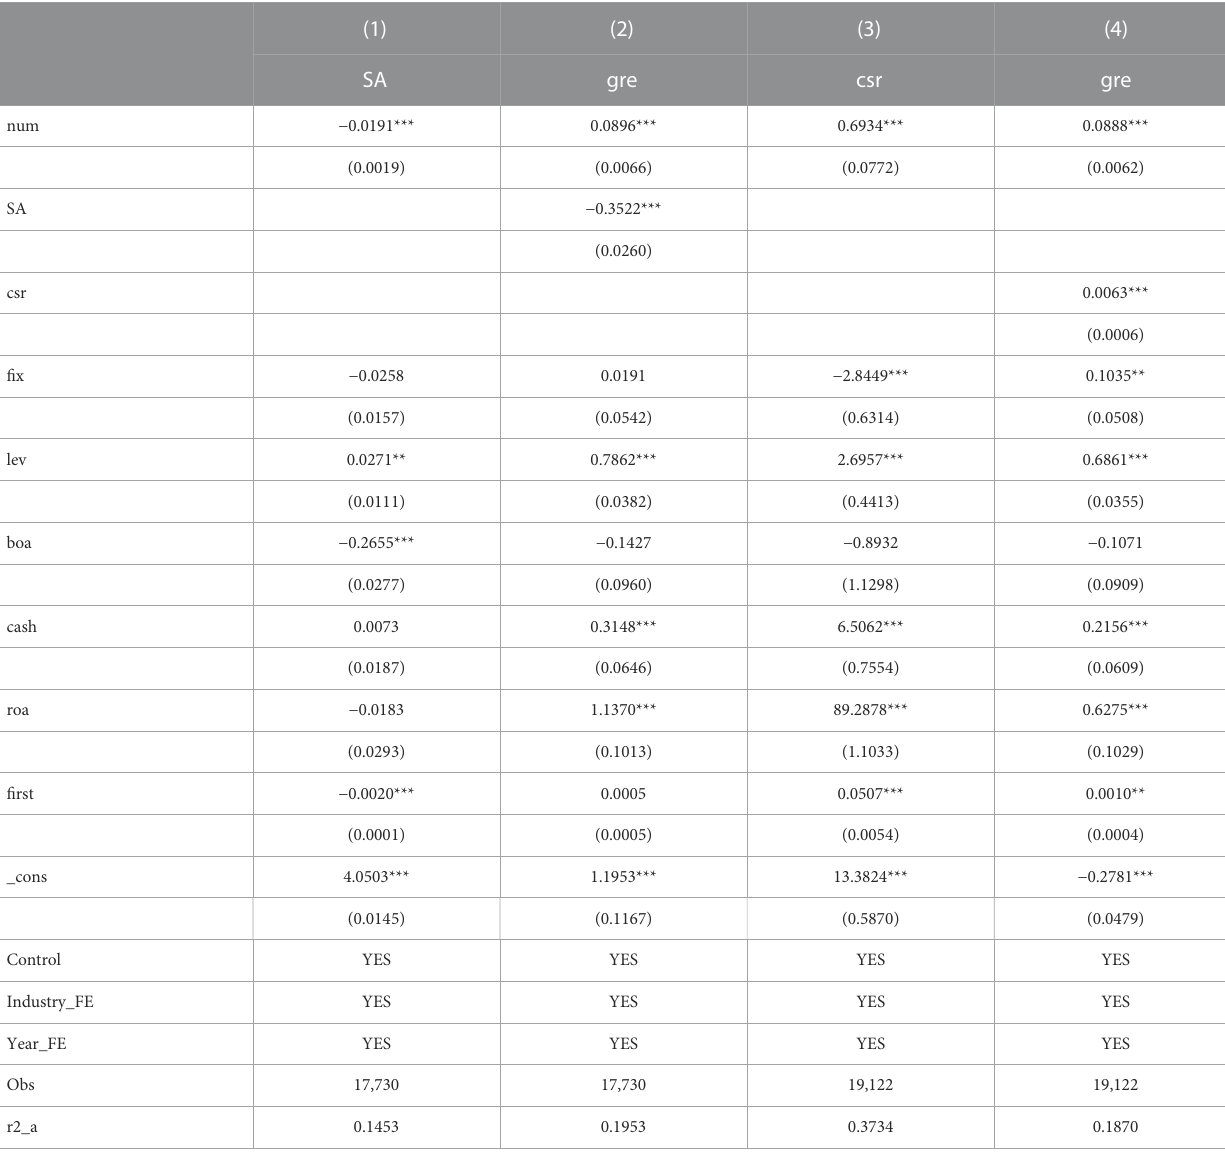
TABLE 6 Mediating effect